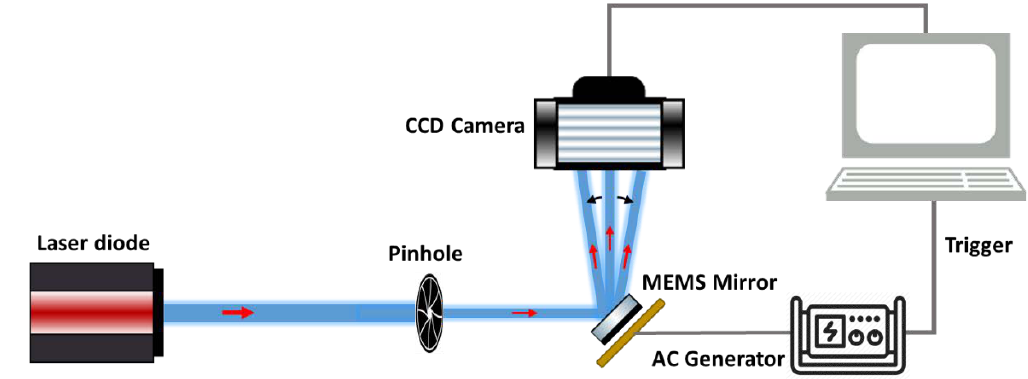
Figure 3. Schematic of the characterization setup of the mechanical properties of the MEMS actuators.